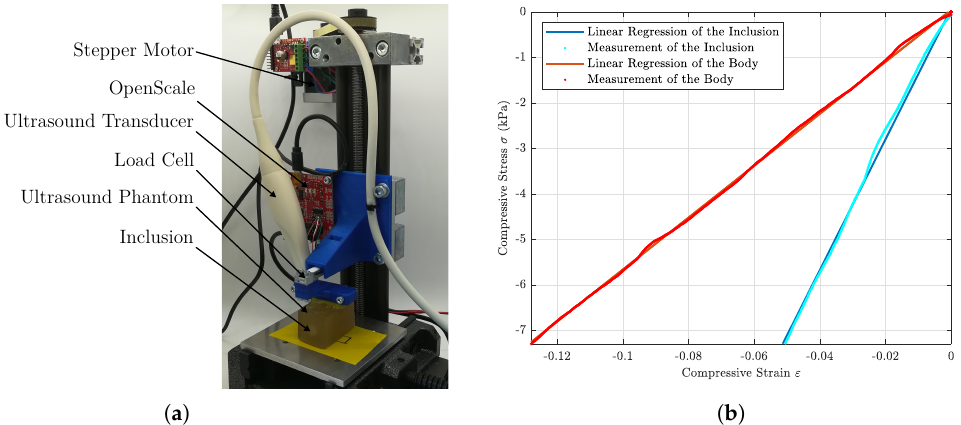
Figure 2. Mechanical measurements of the gelatin phantom. ( a ) Setup for the measurements on the gelatin phantom. ( b ) Stress-strain-curve of the gelatin